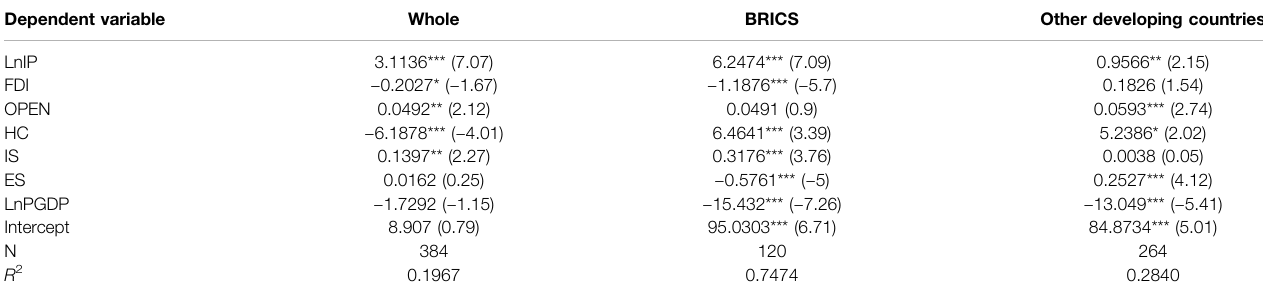
TABLE 3 | Basic regression. Dependent